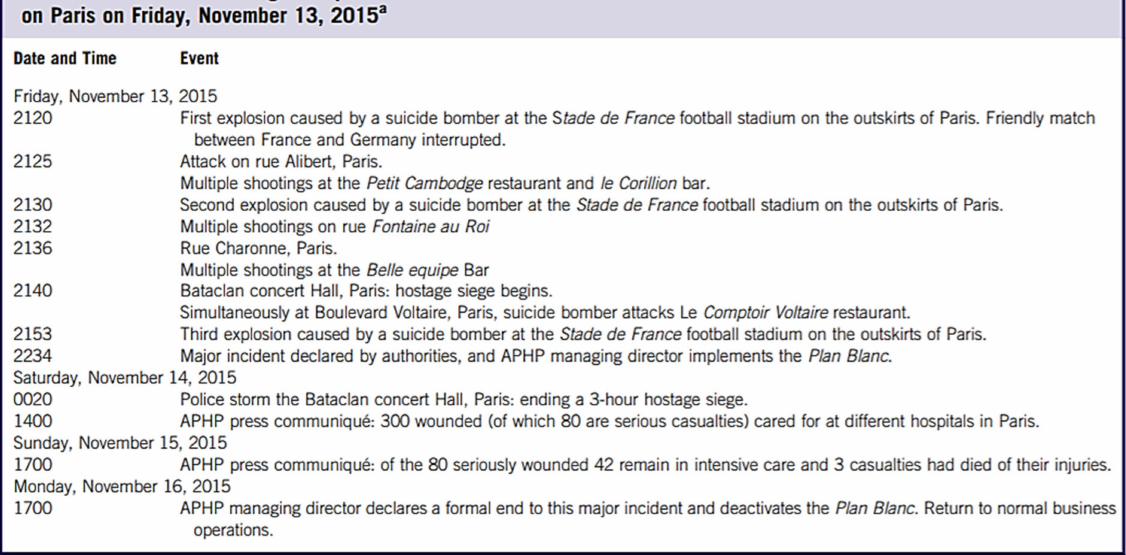
Figure 18. Timeline of events of the November 13, 2015 terrorist attacks in Paris